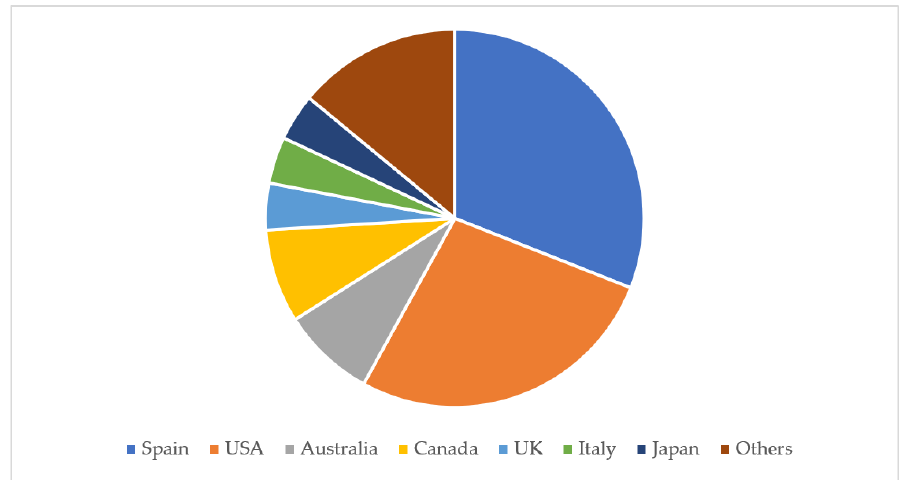
Figure 2. Summary of studies’